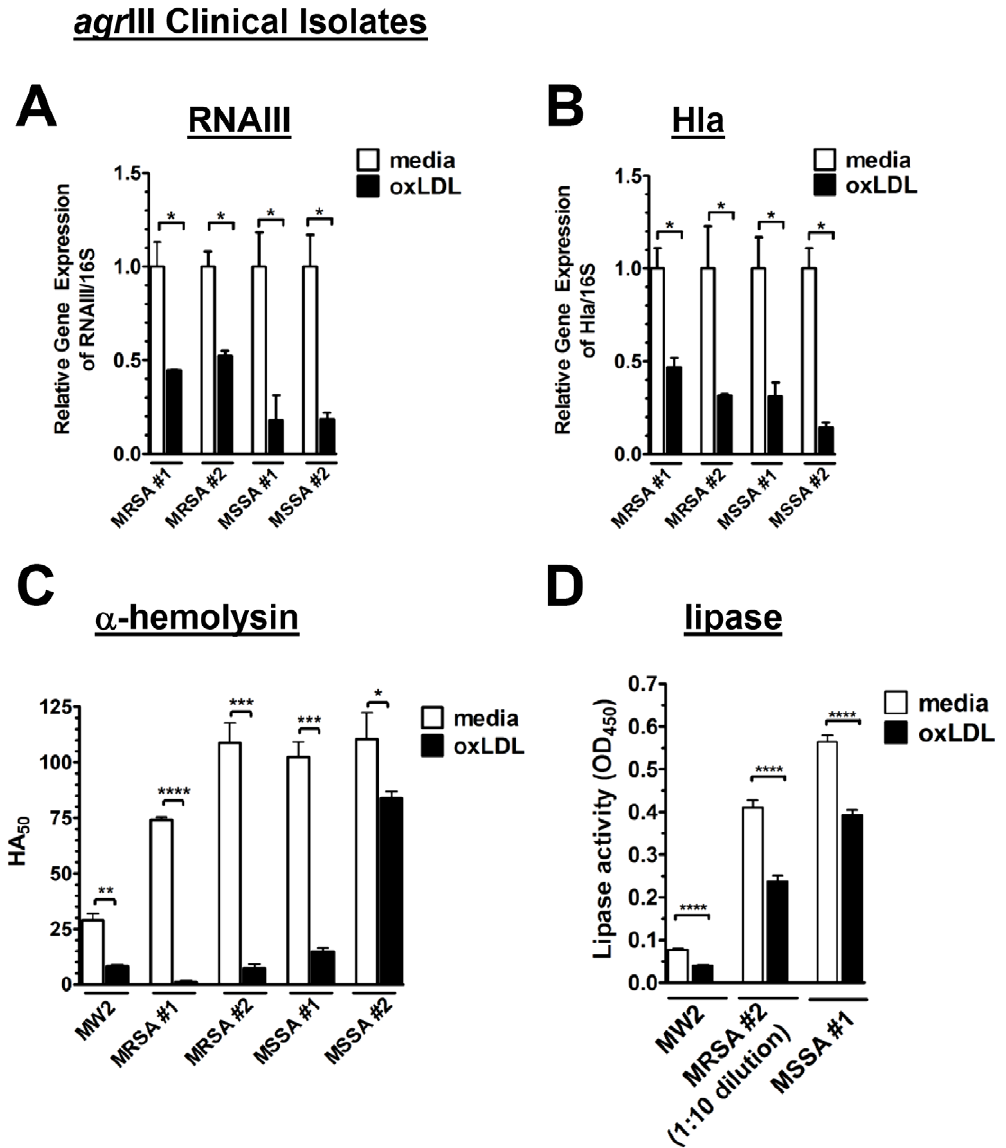
Figure 3. Effect of oxLDL on antagonism of agr III dependent virulence factor production by MRSA and MSSA clinical isolates. (A–D) Bacteria were cultured overnight in the presence of media control or oxLDL (50 nM). (A) RNAIII and (B) hla transcription relative to 16S rRNA was determined by qRT-PCR (C) Alpha-hemolysin content of culture supernatants was measured by the ability to lyse rRBCs. (D) Supernatants from (C) were also assessed for lipase activity determined by rate of cleavage of the triglyceride substrate tributyrin. Data reported as the mean 6 SEM. *, p , 0.05; **, p , 0.01; ***, p , 0.001; ****, p , 0.0001.